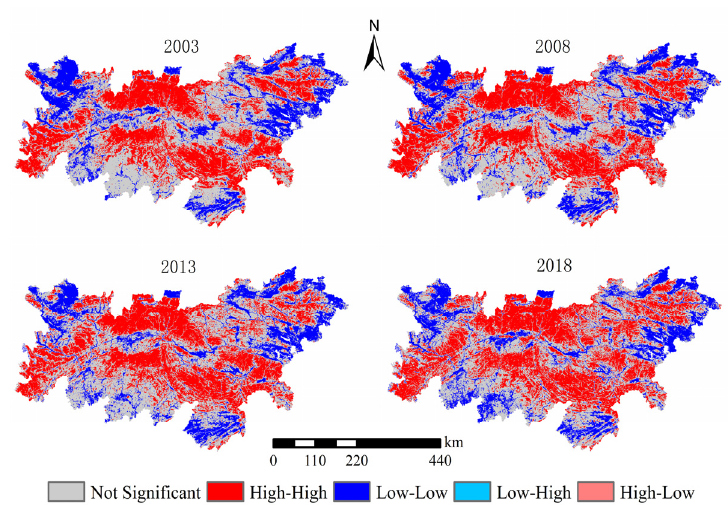
Figure 9. The LISA maps of NDVI in the QBM, 2003–2018.